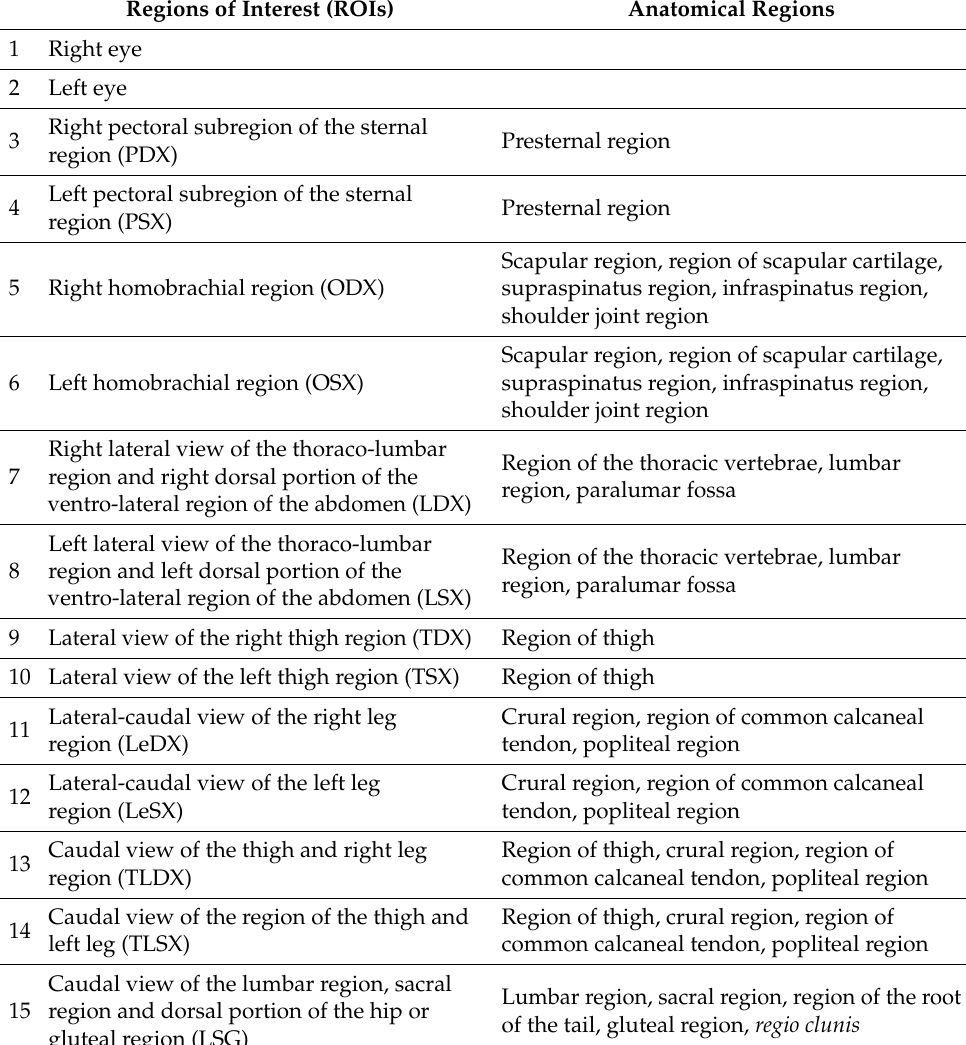
Table 1. Description of the fifteen ROI taken into consideration in the examination and relative anatomi- cal regions as reported by Shaller in Illustrated Veterinary Anatomical Nomenclature in 1992